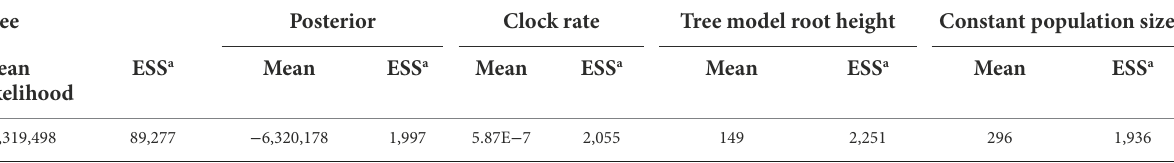
TABLE 2 BEAST run statistics of five combined runs using the Model 23 substitution model, relaxed lognormal molecular clock, and constant population size models.